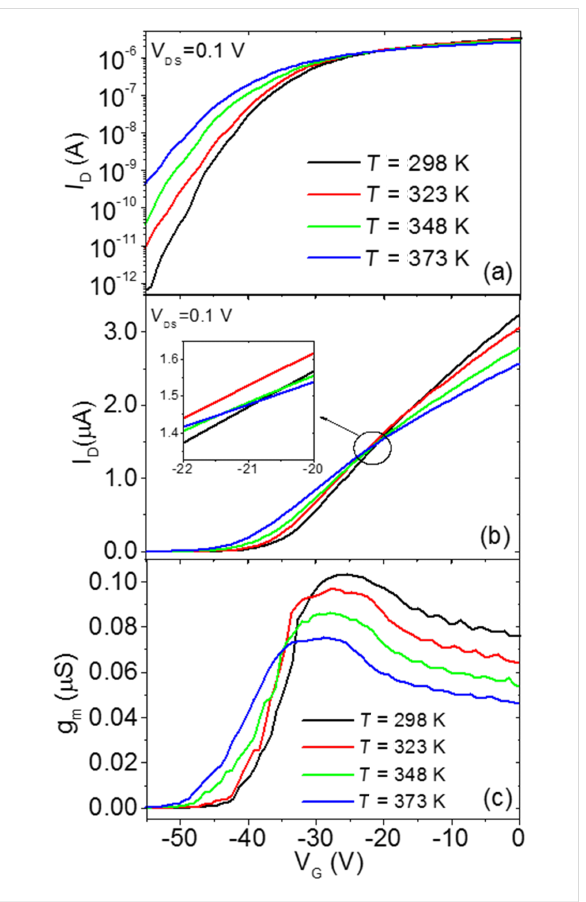
Figure 2: Semilog scale plot (a) and linear scale plot (b) of the transfer characteristics ( I D − V G ) measured at a fixed drain bias ( V DS = 0.1 V) and at different temperatures ranging from 298 to 373 K. (c) Transcon- ductance ( g m = d I D /d V G ) vs V G curves at different temperatures calcu- lated from the I D − V G characteristics in